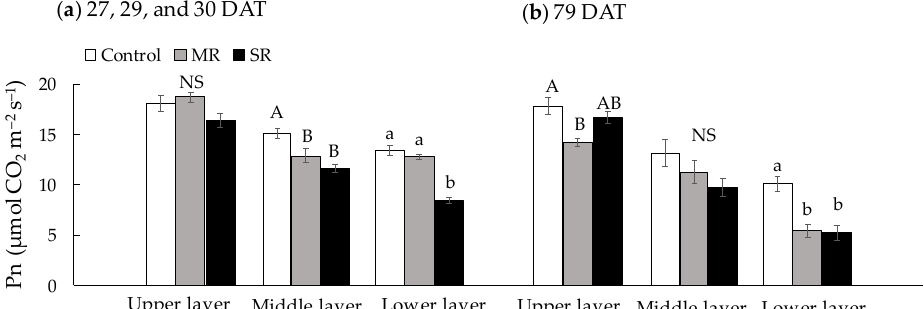
Figure 6. Effects of water stress on net photosynthetic rate (Pn) in the upper, middle, and lower leaf layers of tomato plants on 27, 29, 30 ( a ), and 79 ( b ) DAT. The measurements of Pn in each leaf layer were performed from 10:00 to 14:00. Each value is shown as the mean ± standard error (SE). Different letters indicate significant differences among treatments, as determined using the Tukey–Kramer’s test at p < 0.05 ( n = 6). DAT: days after commencing treatments; MR: moderate wilting–full